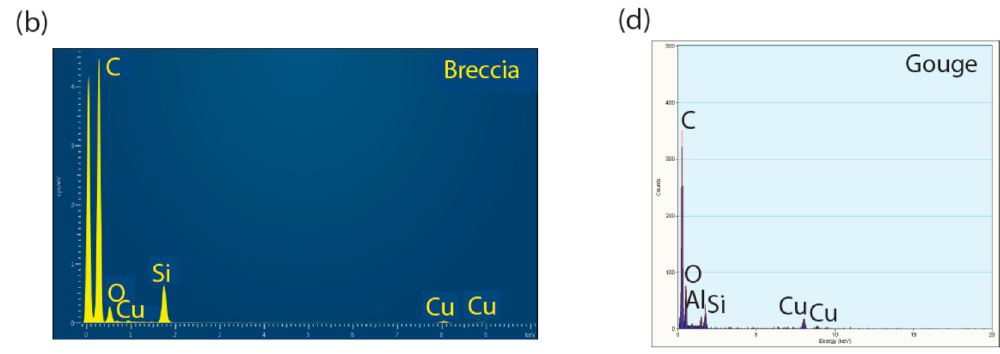
Figure 5. TEM energy-dispersive X-ray spectroscopy (TEM-EDX) analyses on breccia samples and gouge samples. ( a , b ) TEM-EDX of the breccia samples showing that the selected-area electron diffraction (SAED; Figure 4a,b in the main text) is on-average composed of carbon (91.2 and 95.07 wt%, respectively) as the dominant element, whereas sub-elements are copper (0.98 and 0.49 wt%, respectively) (TEM grid), silicon (4.9 and 4.4 wt%, respectively) and aluminum (2.92 and 0.04 wt%, respectively). ( c , d ) TEM-EDX of the gouge samples showing that the SAED (Figure 4c,d in the main text) comprises of on-average carbon (87 and 93 wt%, respectively) as the dominant element, whereas sub-elements are oxygen (8 and 4.9 wt%, respectively), silicon (2.5 and 0.6 wt%, respectively), and aluminum (2.5 and 1.5 wt%, respectively). Table 1. Results of spectra decomposition along the depths for breccia and gouge of the active Wenchuan earthquake fault zone from the WFSD-1.